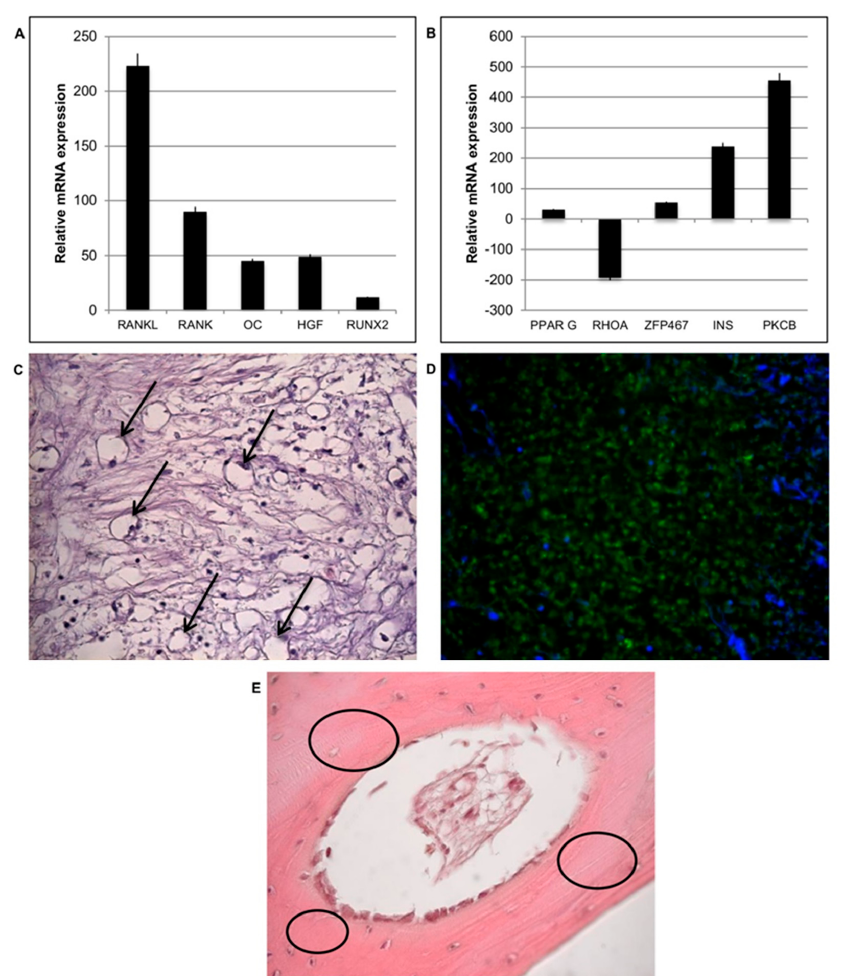
Figure 8. Osteogenesis and adipogenesis events during peri-implantitis. ( A ) Gene expression of most significant genes related to osteogenesis is down regulated in peri-implantitis affected tissue compared to that of the control. ( B ) Gene expression of most significant genes related to adipogenesis are up regulated in peri-implantitis affected tissue compared to that of the control. ( C ) Histological analysis of peri-implantitis affected tissue: presence of adipocytes (black arrows) (20× magnification). ( D ) Positive staining of a hormone related to adipose tissue such as Leptin (green) and nuclei (blue) confirmed the presence of adipose-like cells; (20× magnification) ( E ). Histology of control healthy tissue: no adipose tissue is present. A well-organized osteon structure (black circle) is present. Adipogenic event is activated on peri-implantitis affected tissue: expression of peroxisome proliferator activated receptor gamma (PPARG) and insulin (INS), which regulates fatty acid storage, glucose metabolism and adipogenesis by fat cells, was detected (Figure 8B) and it is up regulated.